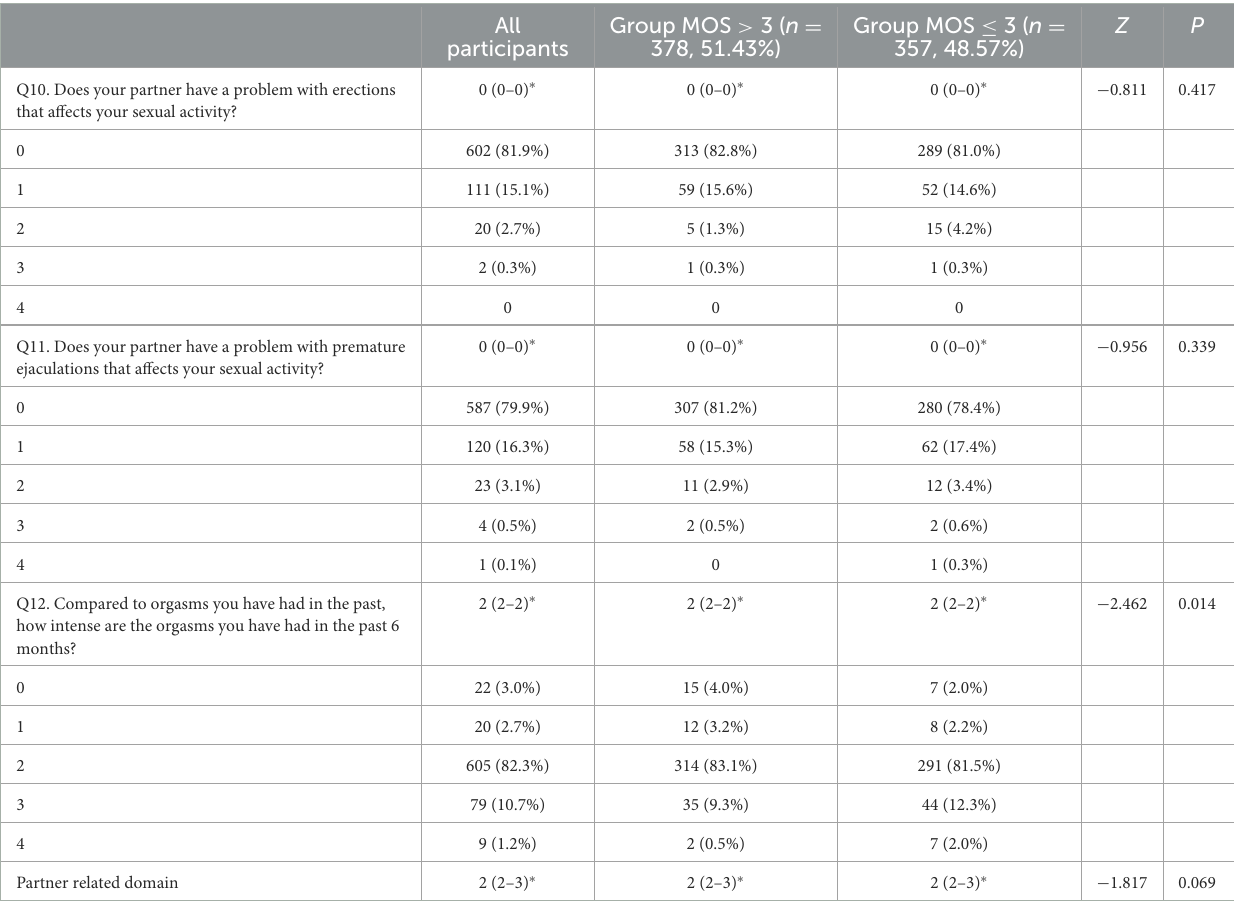
TABLE 6 The scores for the partner-related domain of PISQ-12 for all participants and the results from univariate analysis of the partner-related domain of PISQ-12 between the two groups.